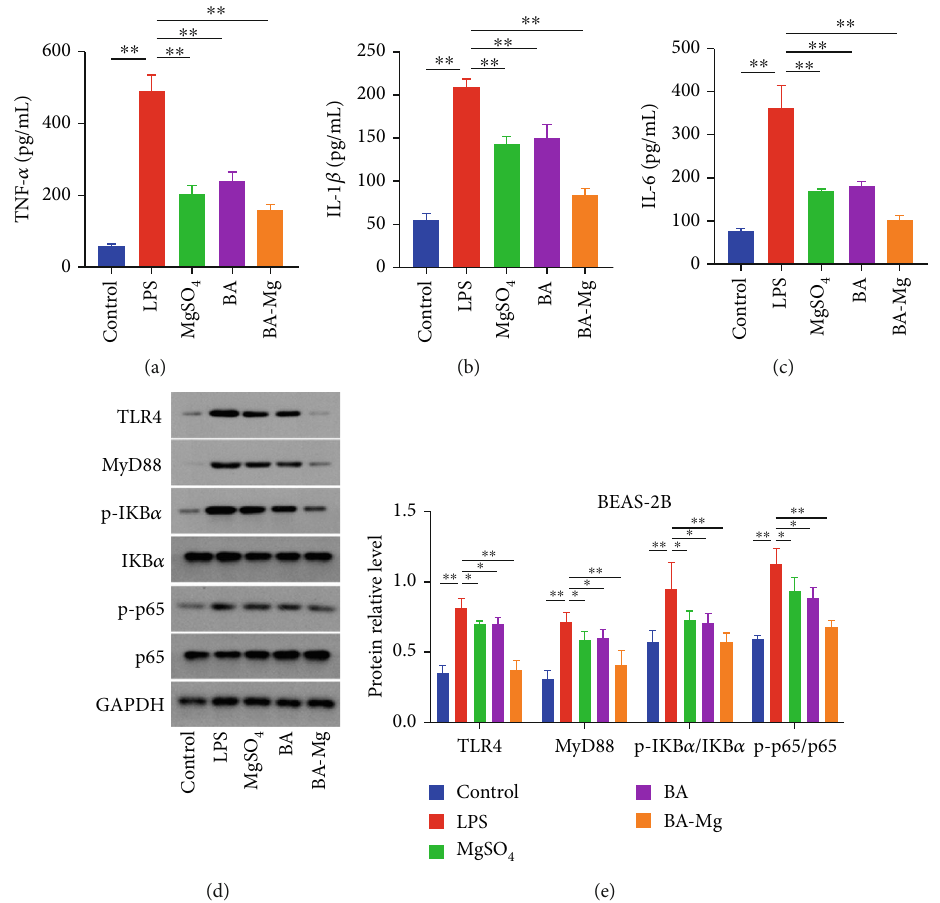
Figure 6: E ff ect of BA-Mg on LPS-induced BEAS-2B cells in vitro. (a – c) E ff ect of BA-Mg on in fl ammatory cytokine expressions in LPS- induced BEAS-2B cells. (d, e) E ff ect of BA-Mg on TLR4/NF- κ B signaling pathway in LPS-induced BEAS-2B cells. At least 3 independent repetitions per experiment were conducted. ∗ P < 0 : 05 , ∗∗ P < 0 : 01 versus LPS